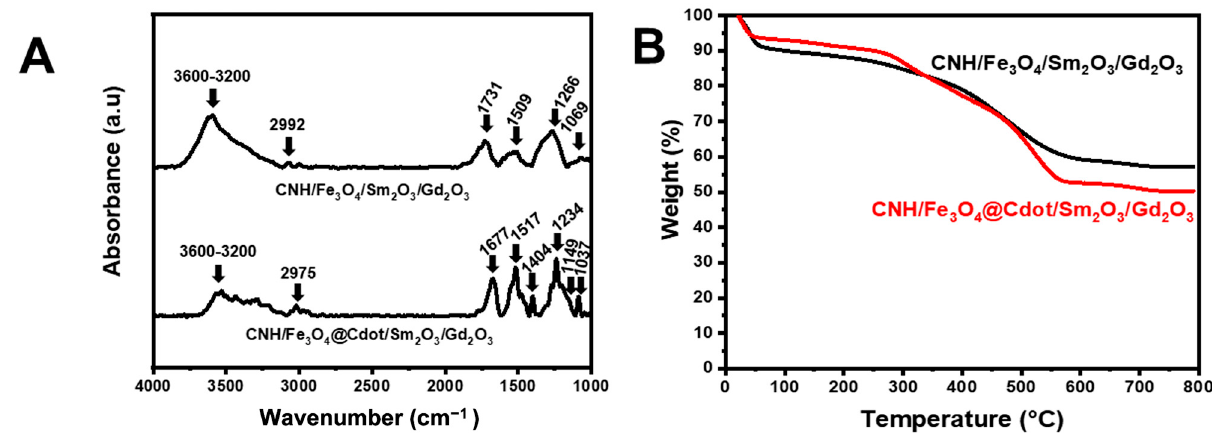
Figure 2. ( A ) FTIR spectra and ( B ) TGA curves of CNH/Fe 3 O 4 /Sm 2 O 3 /Gd 2 O 3 and CNH/Fe 3 O 4 @Cdot/Sm 2 O 3 /Gd 2 O 3